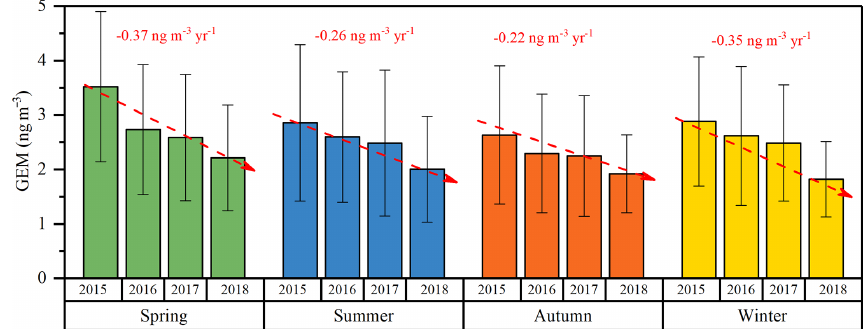
Figure 3. Seasonal variations in GEM concentrations from 2015 to 2018. The variation rates of GEM for each season are also shown in the